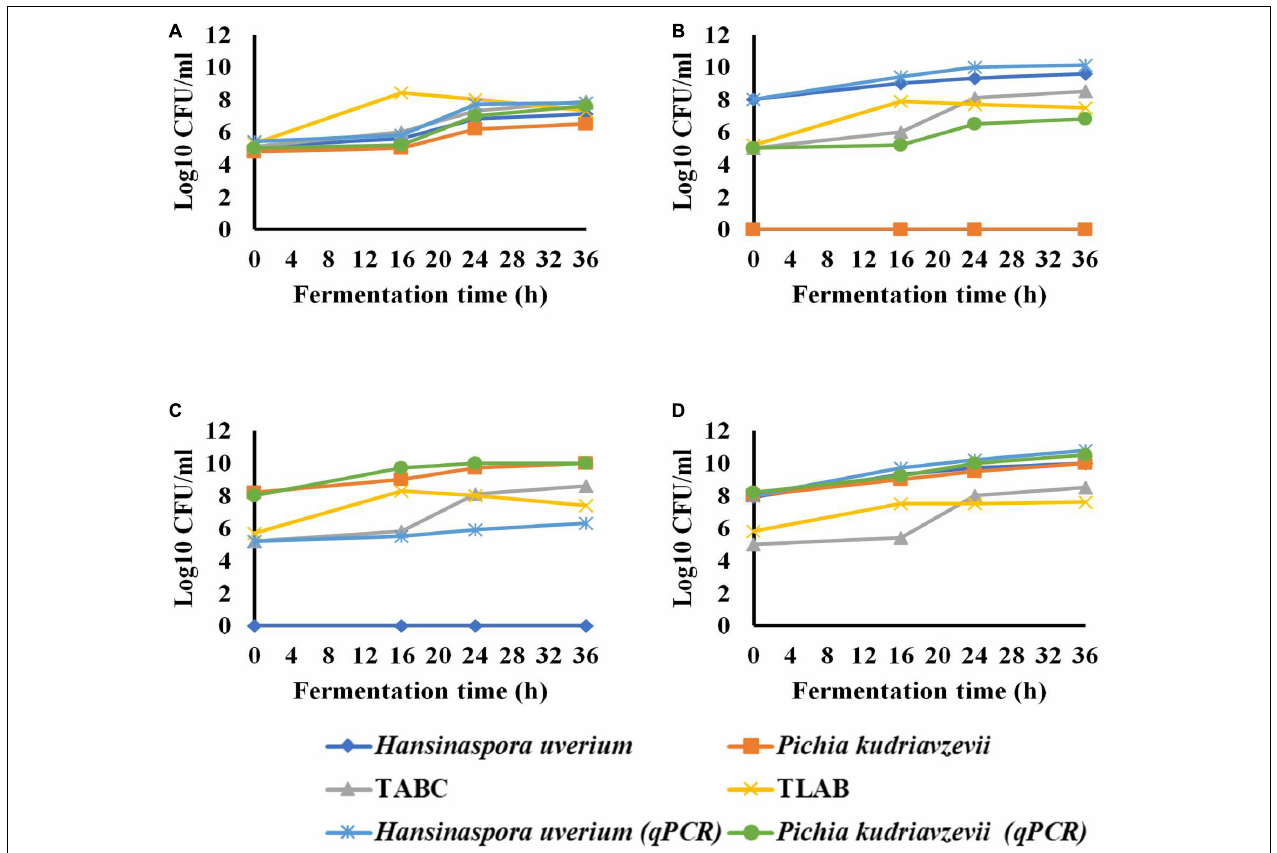
FIGURE 1 | The growth of yeasts during wet coffee beans fermentation; spontaneous (control) (A) ; Hansinaspora uvarum inoculations (B) ; Pichia kudriavzevii inoculations (C) and inoculation with H . uvarum and P. kudriavzevii Combined (D) . TABC, total acrobic bacteria count; TLAB, total lactic acid bacteria; qPCR, quantitative real time PCR. Microbial populations were determined by plate coubting with SD of means less than 5% and qPCR with SD of means ranged from 0.006 to 0.09 log10 CFU/ml